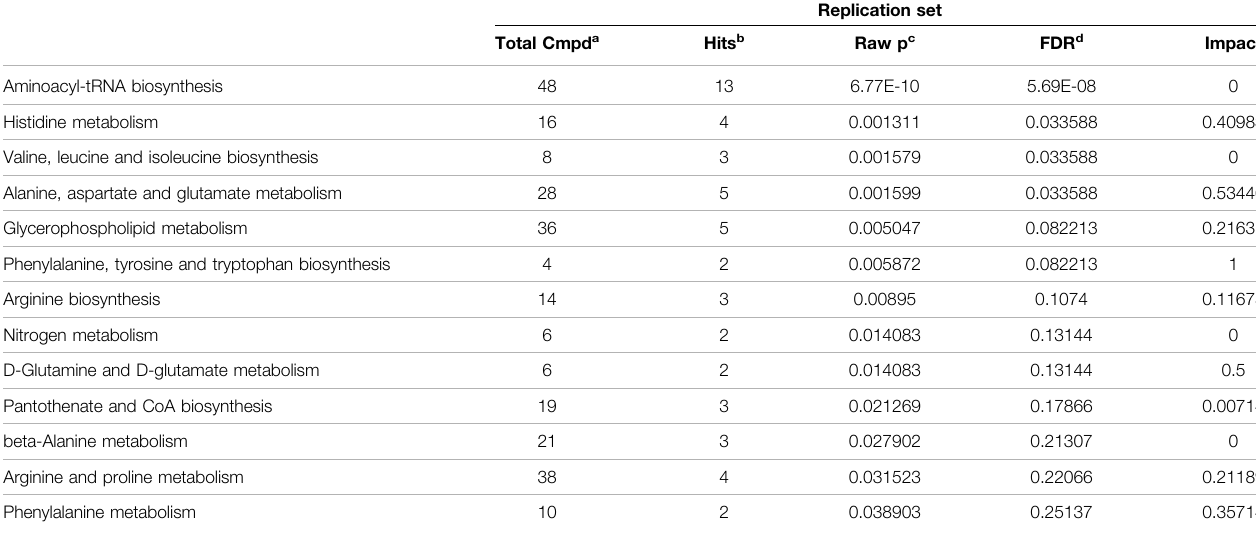
TABLE 4 | Pathway analysis of COPD patients against Controls in Replication set.